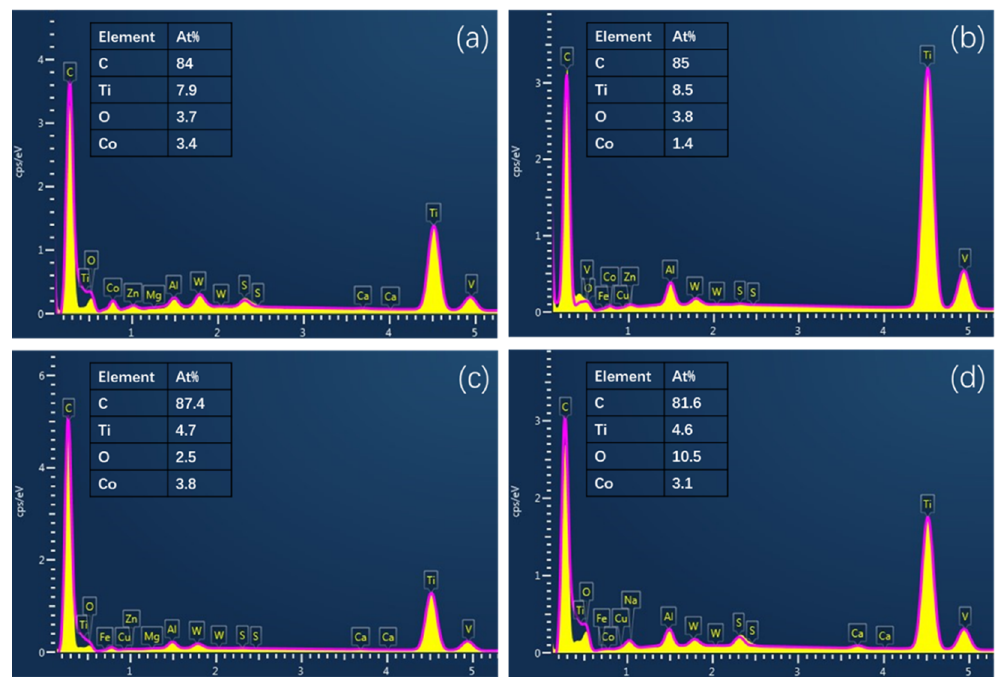
Figure 12. Residual elements on the worn areas of the four PCD inserts: ( a ) 002A, ( b ) 002E, ( c ) 302A, and ( d ) 302E.